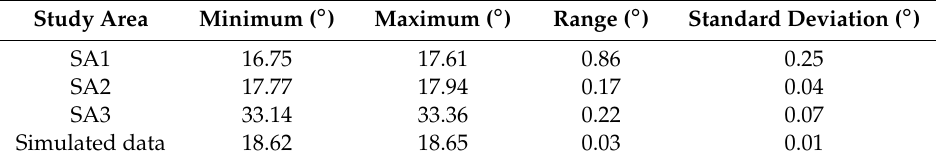
Table 6. Descriptive statistics of mean aspect in study areas 1–3 and simulated data. Table 5. Descriptive statistics of mean slope in study areas 1–3 and simulated data.